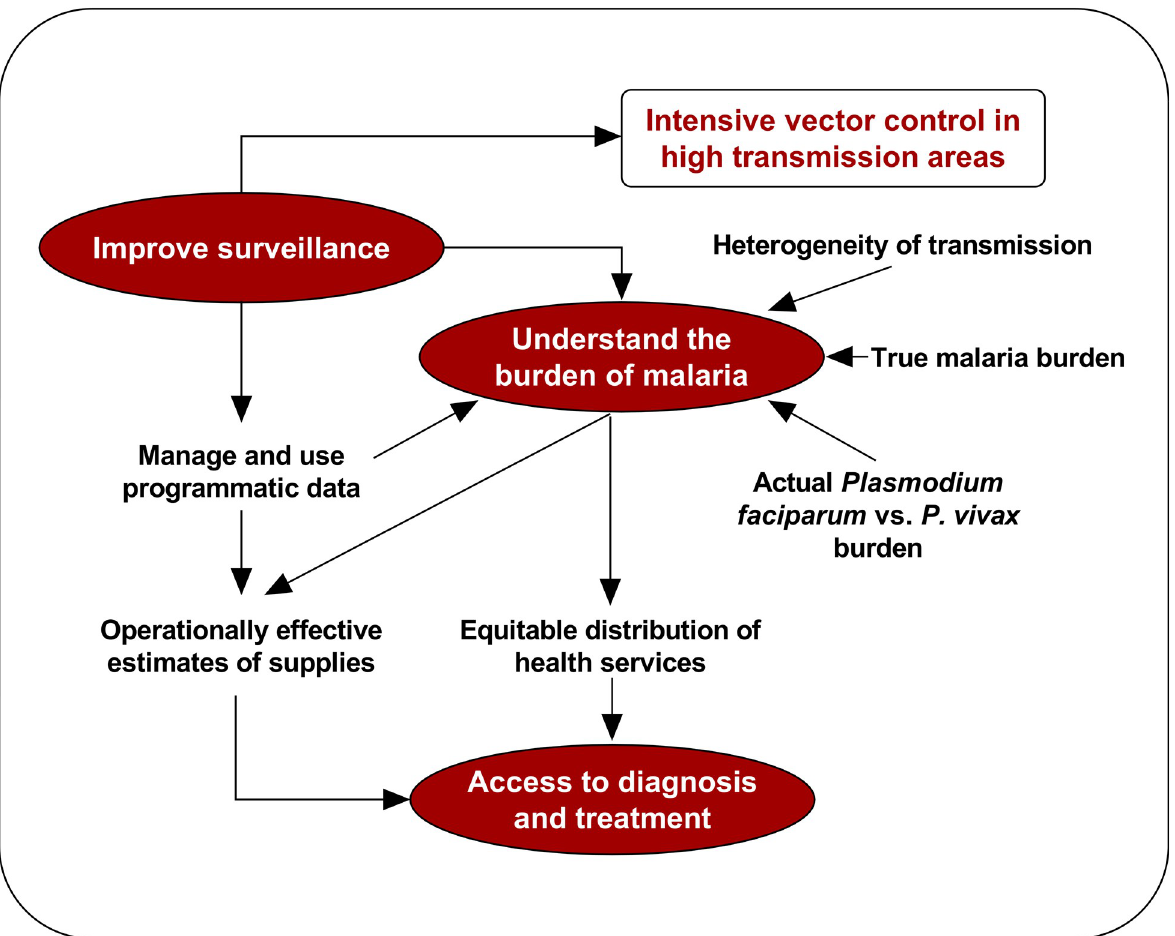
Fig 8. Framework for scale up of access to malaria diagnosis and